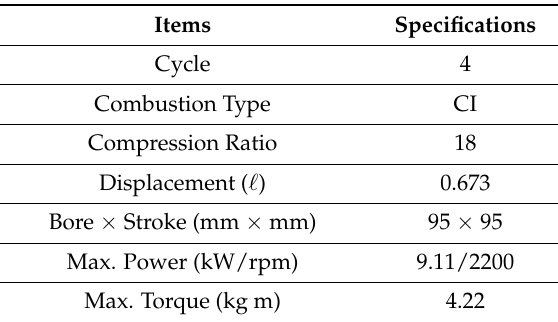
Table 1. Engine specifications in this